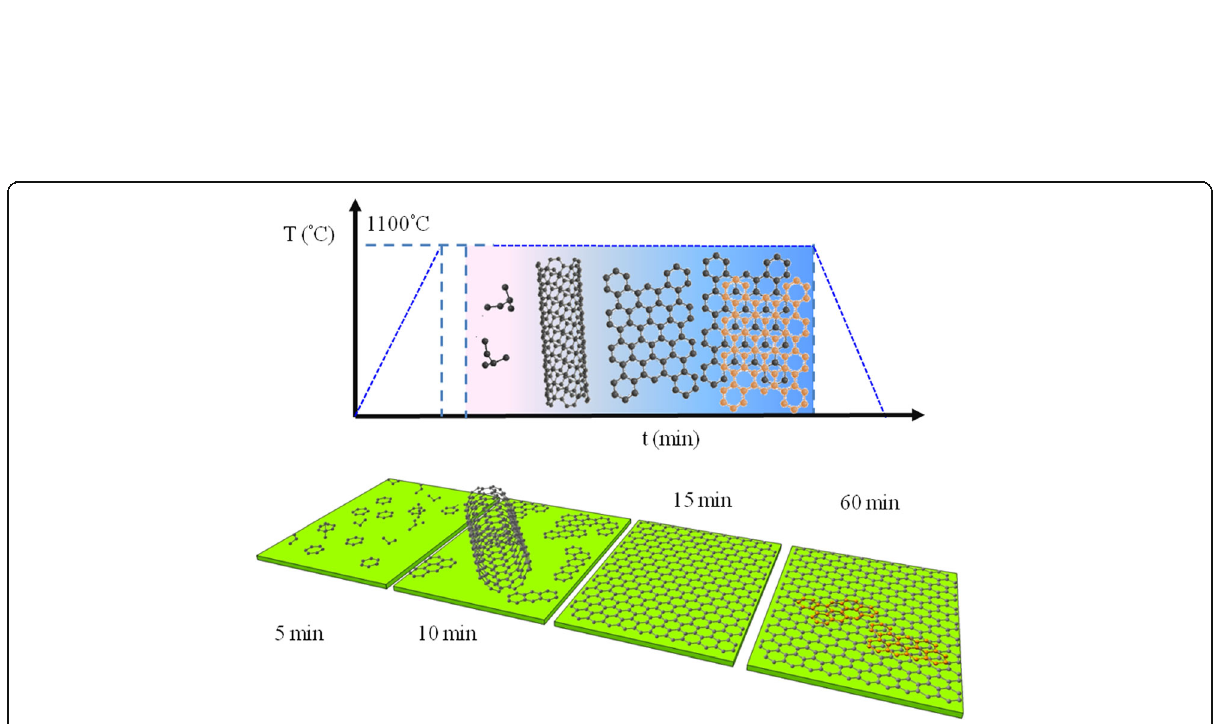
Fig. 4 Schematic illustration of graphene growth mechanism on SiO 2 from ethanol. Bottom panel depicts the evolution of carbon-based nanostructures including carbon nanoparticles, mixture of CNTs and carbon nanoparticles, multilayer graphene (MLG) with some defects, and mono- to few-layer graphene for growth time of 5, 10, 15, and 60 min, respectively